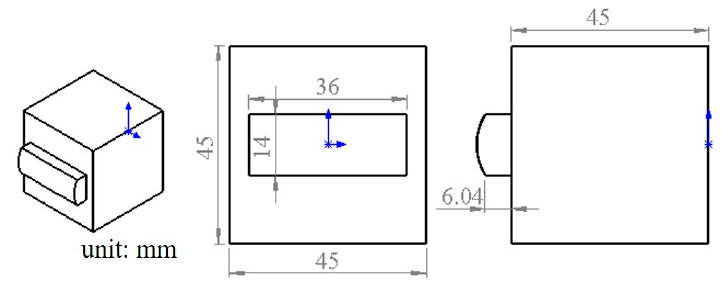
Figure 5. Dimensions of the designed surface. Table 3. Positions of the centers of the fiducials in the designed model.